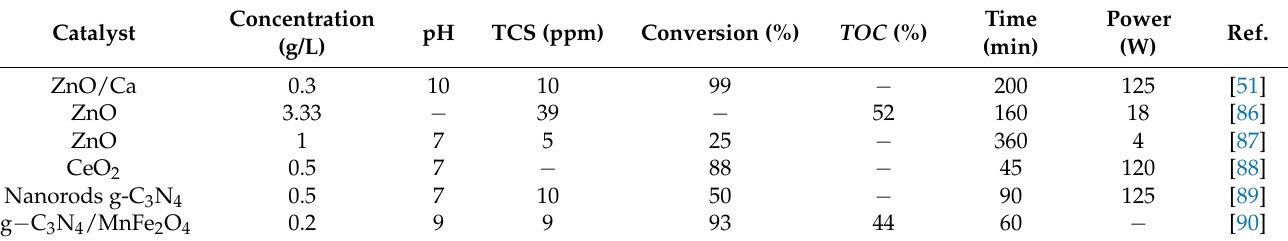
Table 4. Comparison of articles with photodegradation of triclosan.